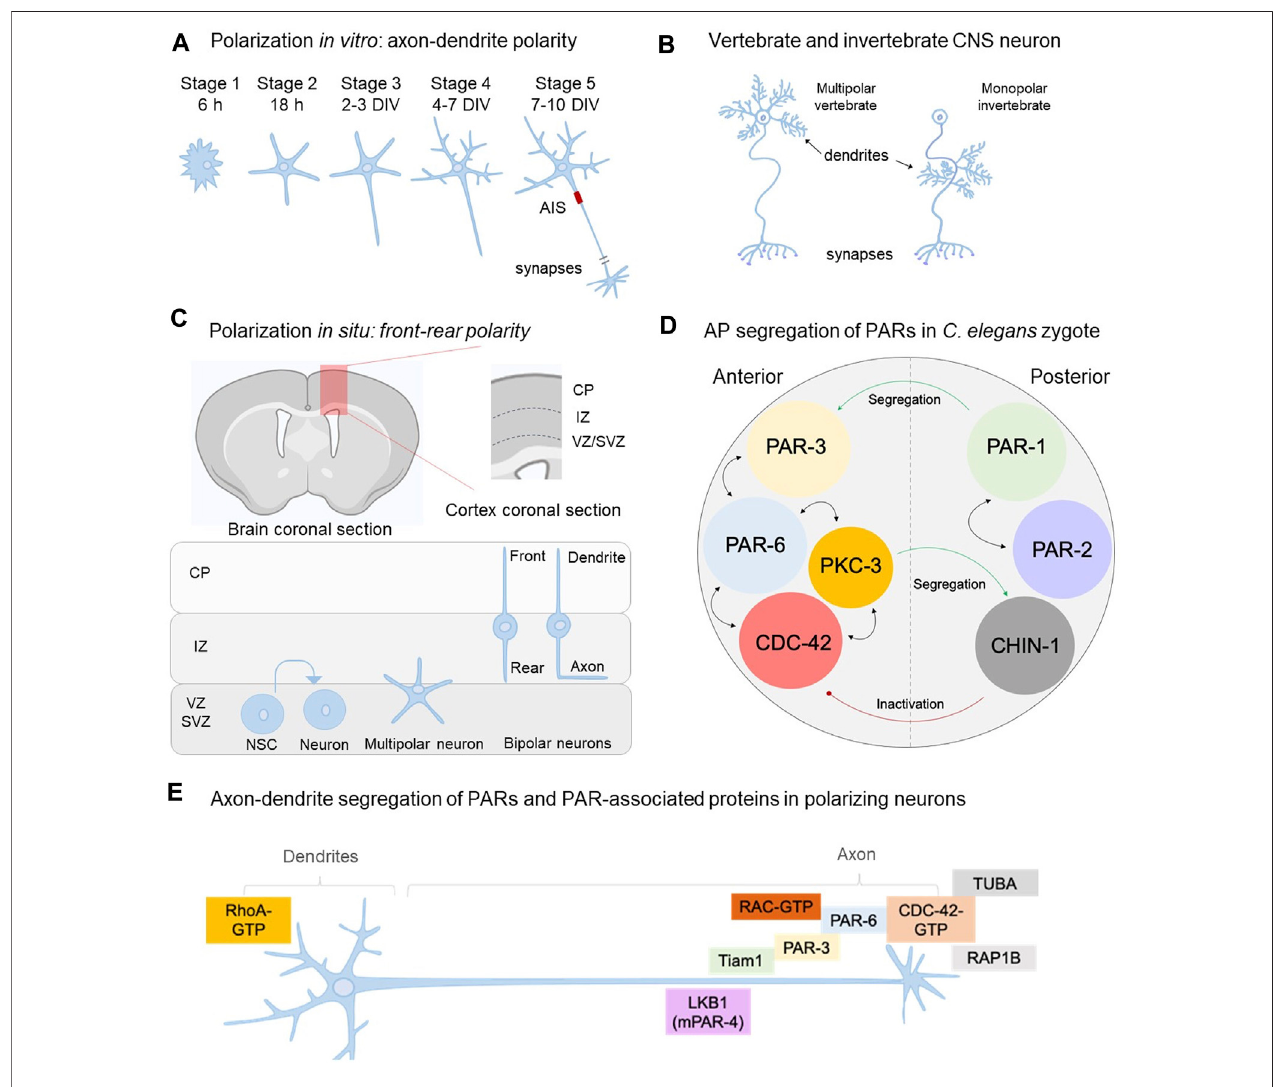
FIGURE 1 | PARs, the polarity complex and their role on neuronal polarity acquisition. (A) Polarization of neurons in vitro — isolated from embryonic murine hippocampi or brain cortices — occurs through the sequential transformation of rounded postmitotic cells ( stage1 ) to fully polarized neurons able to form synapses with other neuronal and glial cells ( stage 5 ). (B) Representative multipolar vertebrate motor neuron with dendritic process at the soma and monopolar invertebrate motor neuron where dendritic branches develop from a thin primary neurite that extends towards the neuropil. (C) Polarization of cortical neurons in situ starts after neurogenesisintheVZ(ventricularzone)ofthedevelopingbraincortexenriched inneuralstemcells(NSC). Then,postmitoticneuronsadoptamultipolarphenotypeand migrate from the SVZ (subventricular zone) to the IZ (intermediate zone) adopting the front-rear polarity. Dendrites and the axon will emerge from front (leading) and rear (trailing) processes, respectively. (D) Segregation of PARs in the C. elegans zygote establish a feedforward circuit aiming the maintenance of the AP axis. This circuit is reproduced across species, cell types and developmental stages to allow cell polarity. For example, PAR-1 phosphorylates PAR-3; a modi fi cation that allows PAR-3 anterior segregation. In addition, CHIN-1 is a CDC-42 GTPase located in the posterior domain, preventing CDC-42 activation outside the anterior pole. Thus, PARs establish mutual exclusion associations to maintain the circuitry. Bidirectional arrows mean interaction/recruitment. (E) Distribution of PARs in polarizing neurons (stage 2 – 3 transition and stage 3 in vitro ) allows axon-dendrite formation in polarizing neurons in vitro . PAR-3, PAR-6, PKC-3, CDC-42 (namely “ polarity complex, PC ” ) assemblewithTiam1 (Rac ’ sGEF) and RAC through PAR-3 and PAR-6.RAP1B(CDC-42 activator) and TUBA (CDC-42 ’ sputative GEF) also segregate into the nascent axon supporting CDC-42 activation (GTP state) and consequently the